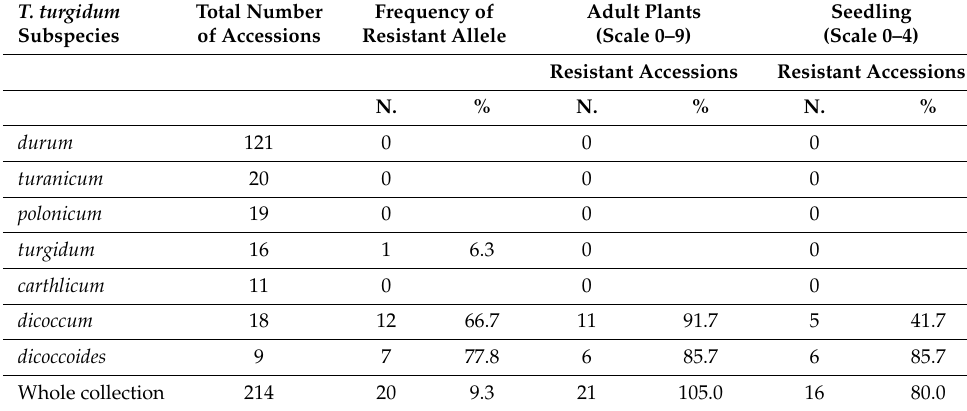
Table 2. Frequency of the Pm36 resistant allele (chromosome regions included by the flanking markers IWB7454 and IWB22904) in a collection of 214 tetraploid wheat accessions evaluated for their reaction to Blumeria graminis f . sp. tritici at adult plant and seedling (race O2) stages. All lines were classified into two groups with resistant lines scoring 0–2 at seedlings and adult plants, and susceptible lines scoring 2.1–4.0 at seedlings and 2.1–9.0 at adult plants [47]. T. turgidum Total Number Frequency of Adult Plants Subspecies of Accessions Resistant Allele (Scale